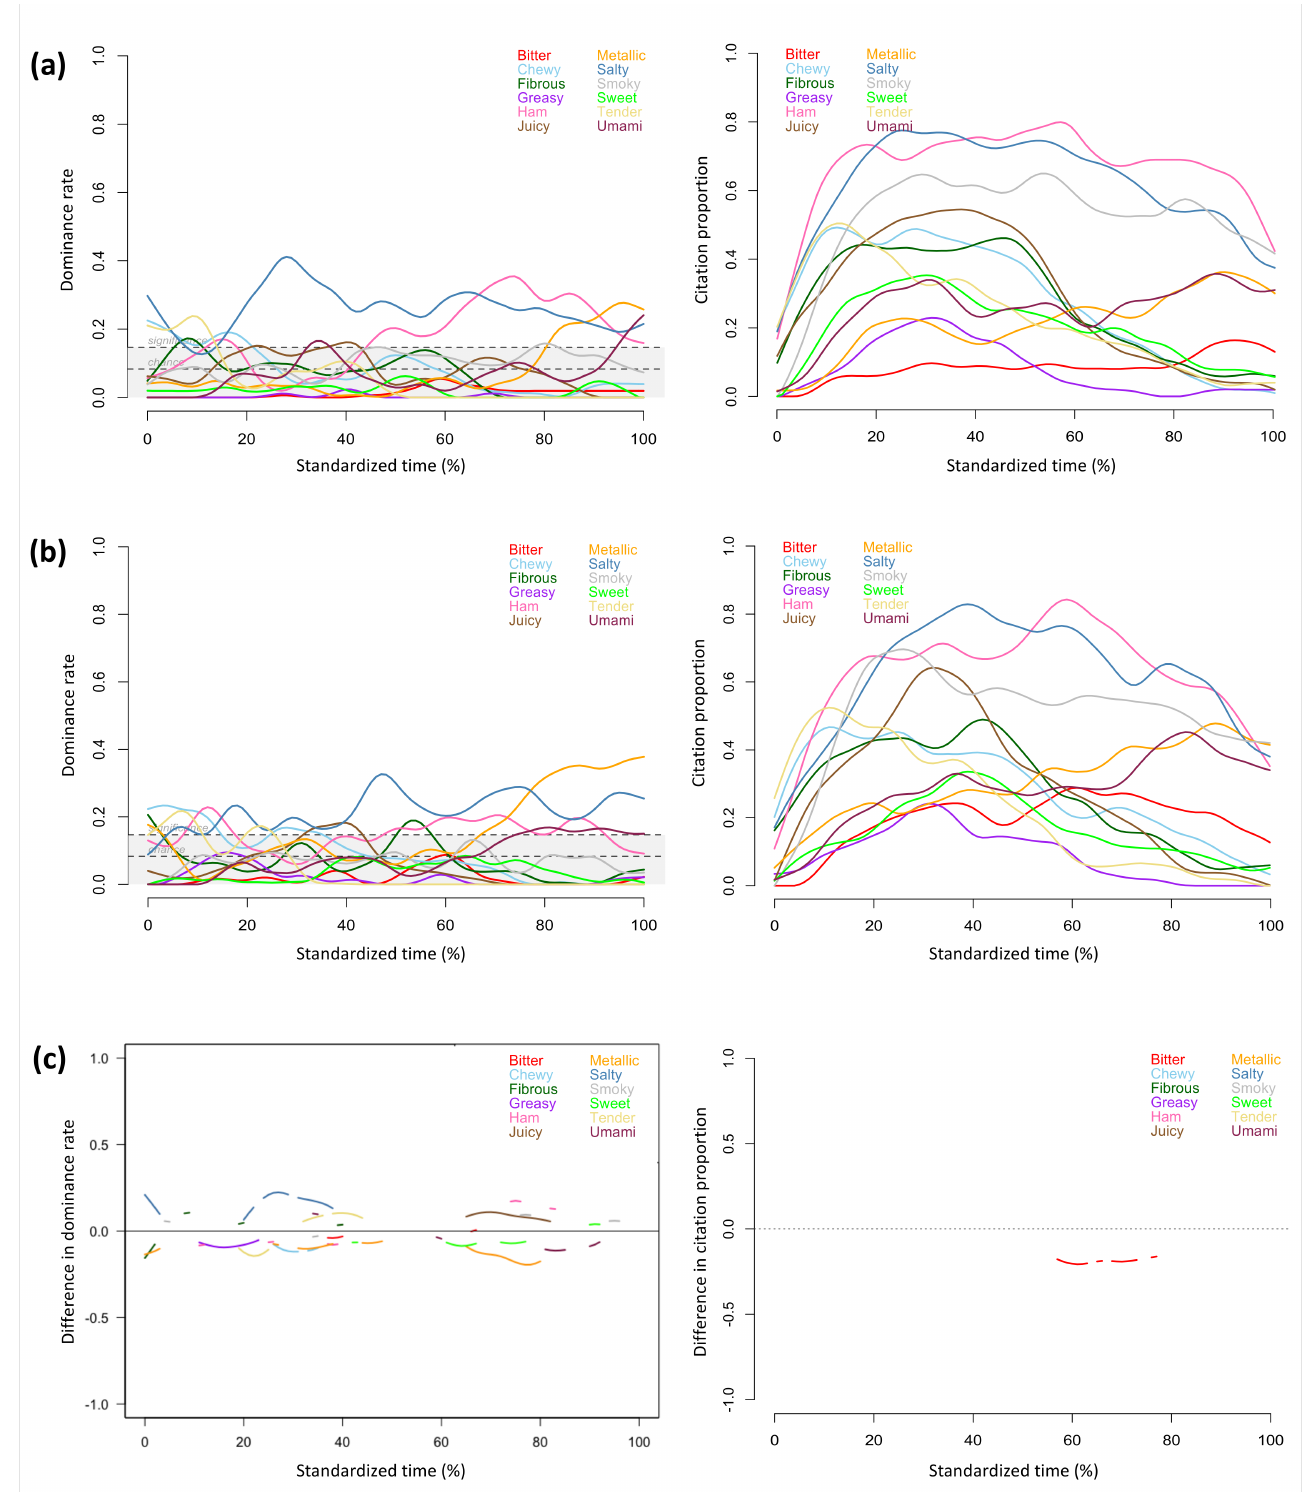
Figure 3. Temporal profiles for regular ( a ) and sodium-reduced ( b ) ham, and significant difference curves ( c ) obtained by TDS (left) and TCATA (right) (n =